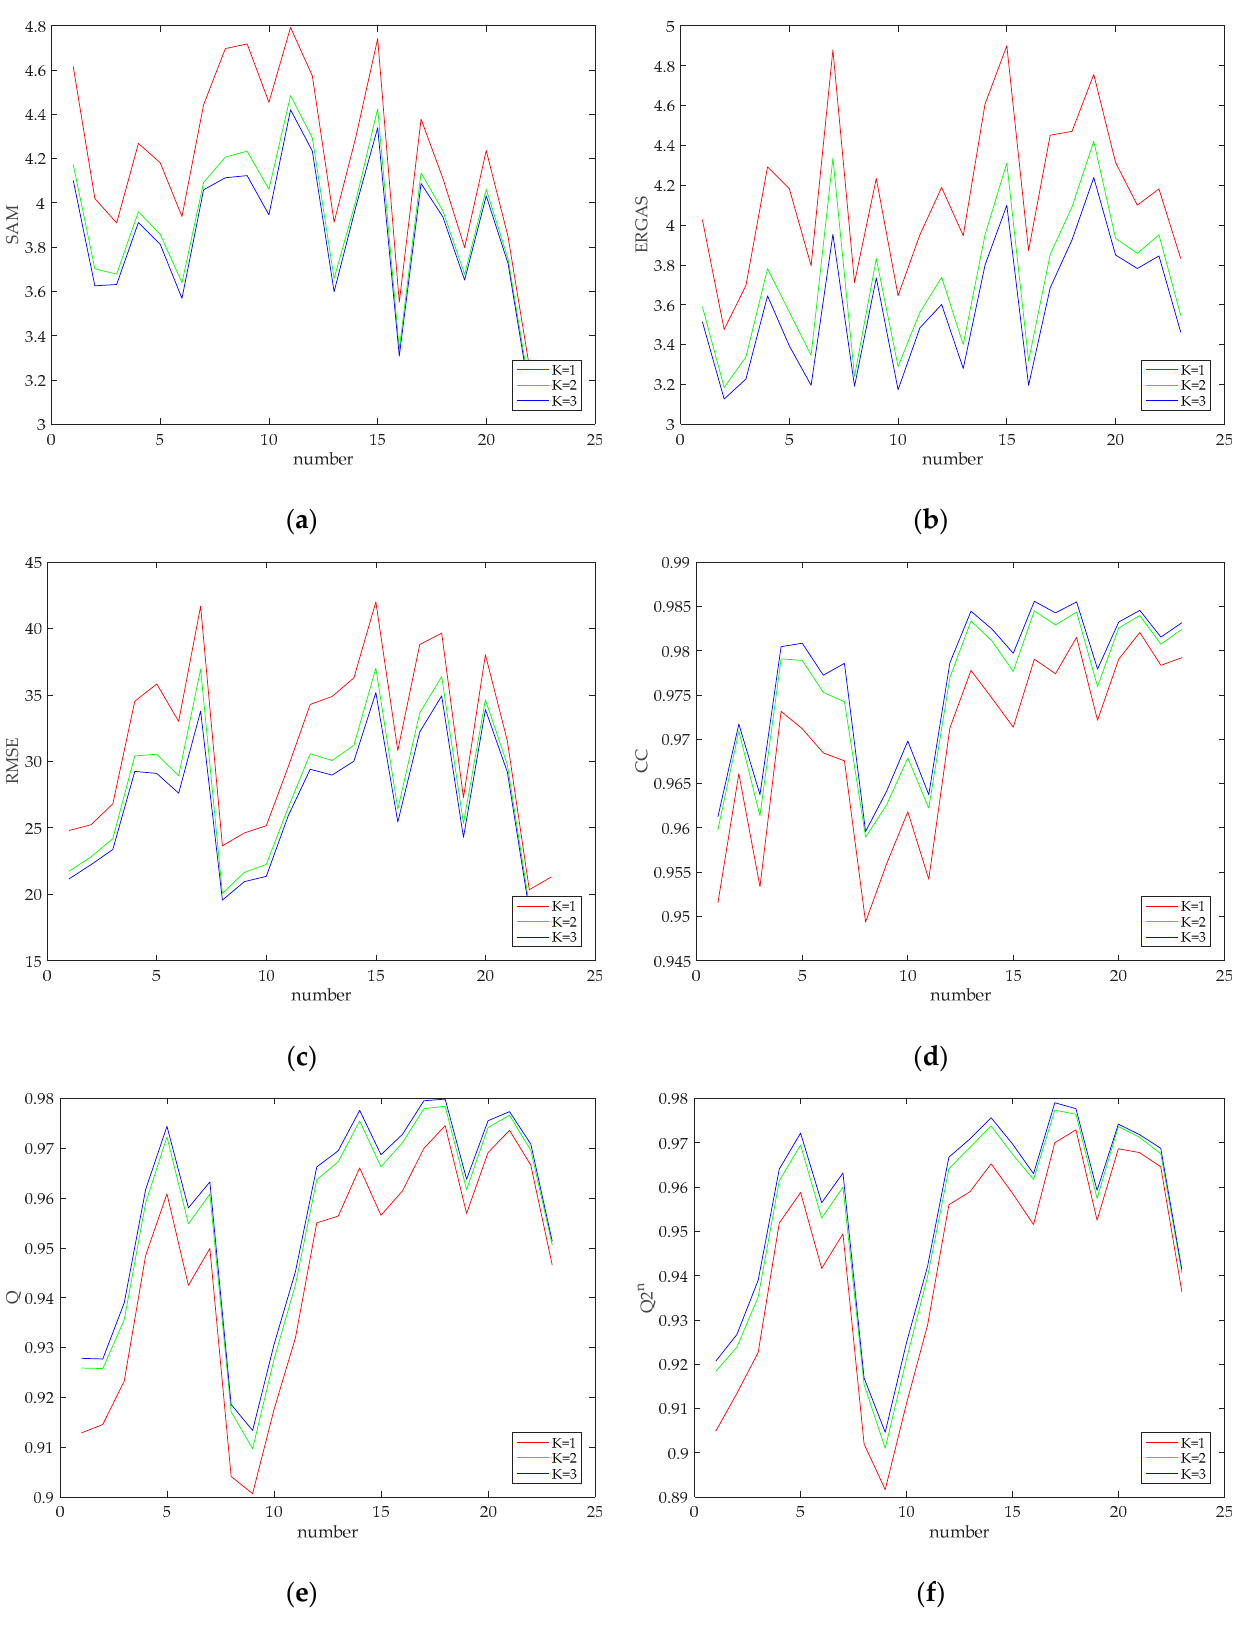
Figure 3. Quality indicator curves of the fused image with network level set to 1, 2, and 3 on the QuickBird dataset. ( a ) SAM; ( b ) ERGAS; ( c ) RMSE; ( d ) CC; ( e ) Q; ( f ) Q2 n .